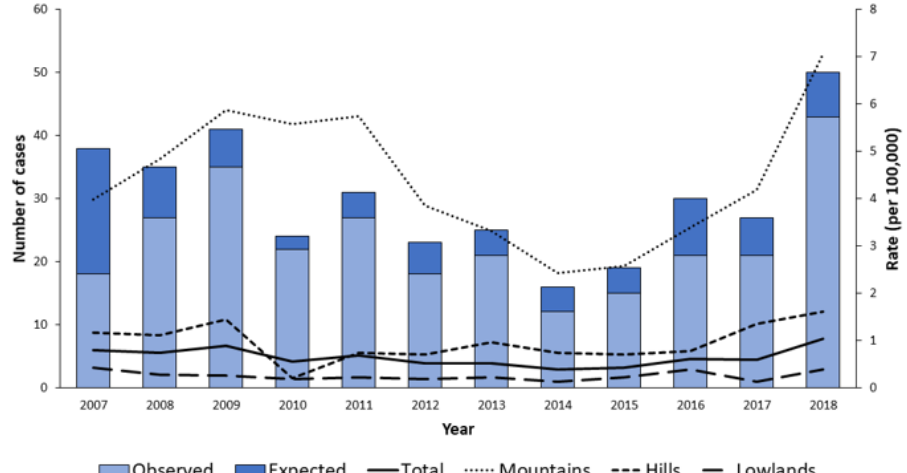
Figure 5. Trend of the adjusted rate and number of cases by geographical area (2007–2018) (Adapted from ref. [12]).